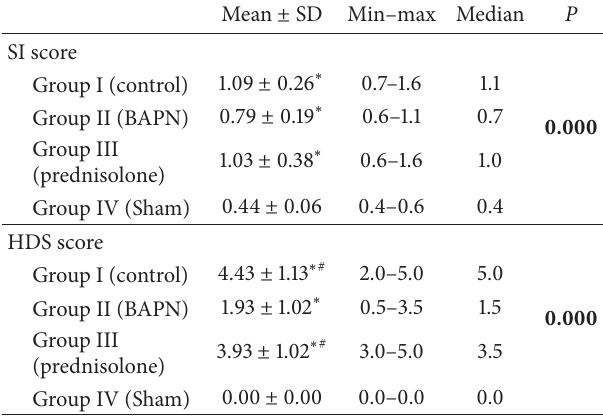
Table 1: Mean histopathological tissue damage score and stenosis index values.